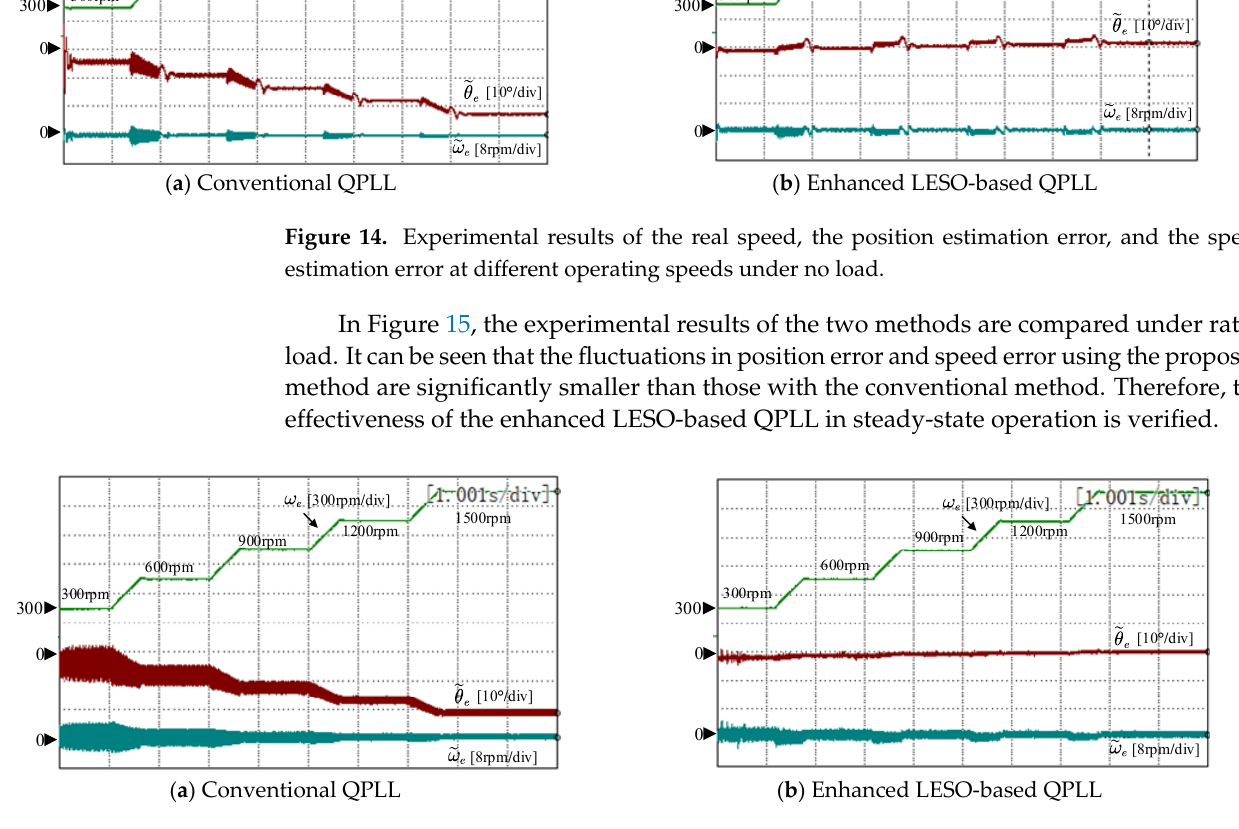
Figure 15. Experimental results of the real speed, the position estimation error, and the speed estimation error at different operating speeds under rated load.